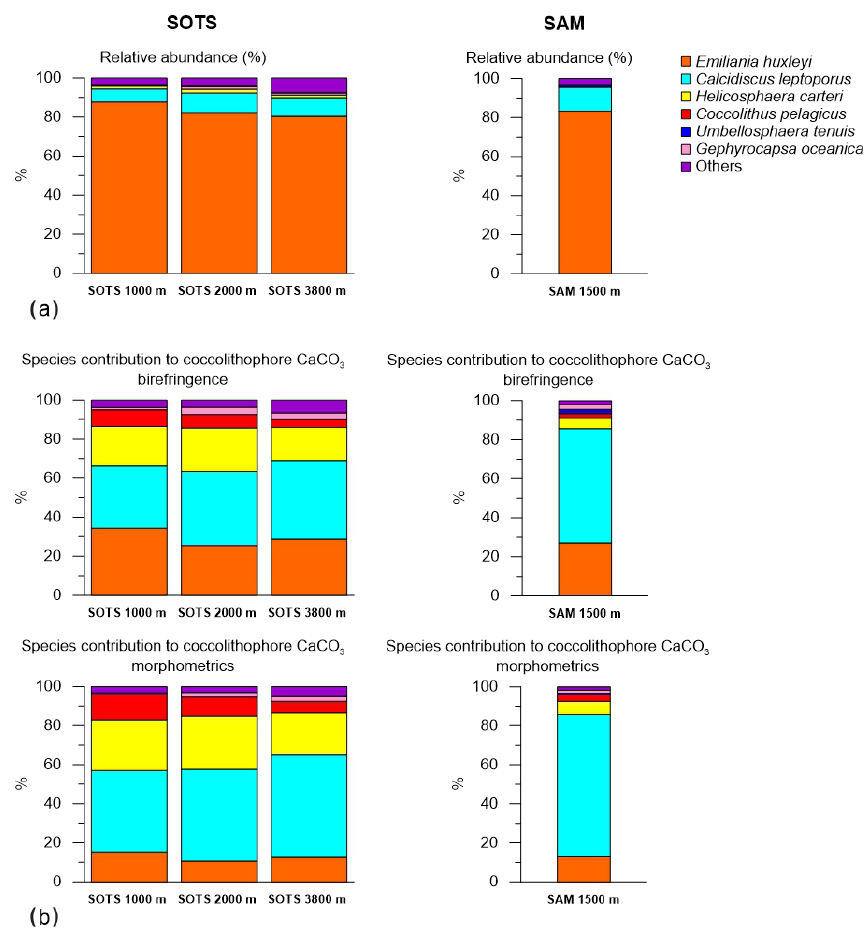
Figure 3. (a) Annualized integrated relative abundance of the most important coccolithophore species in the SOTS and SAM sediment trap records. (b) Fractional contribution of coccolithophore species to total coccolithophore CaCO 3 export in the SOTS and SAM sediment traps.